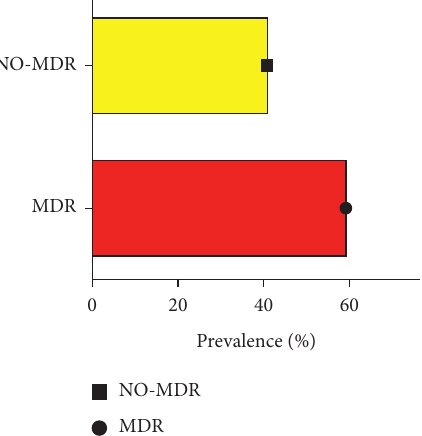
Figure 3: Distribution of MDR and NO-MDR bacterial strains isolated from medical devices ( p value <